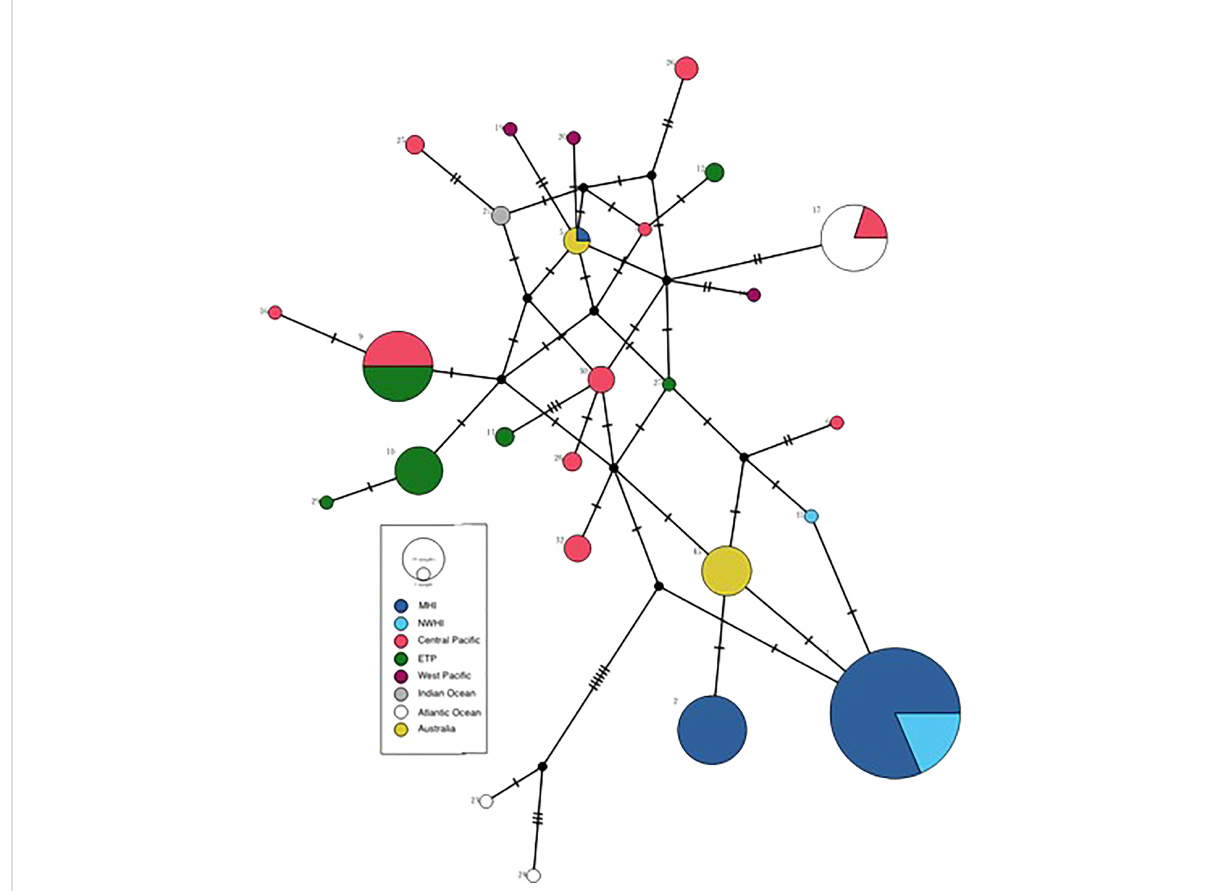
FIGURE 5 Median joining network of false killer whale haplotypes from this study (haplotype 45) and those published by Martien et al. (2014) and Crofts et al. (2019). Node size is proportional to the number of samples possessing that haplotype, while colours indicate the geographic regions in which the haplotype has been identi fi ed. Black nodes represent undetected haplotypes. Hash marks indicate the number of substitutions between haplotypes. Strata are as de fi ned in Figure 1 of Martien et al.